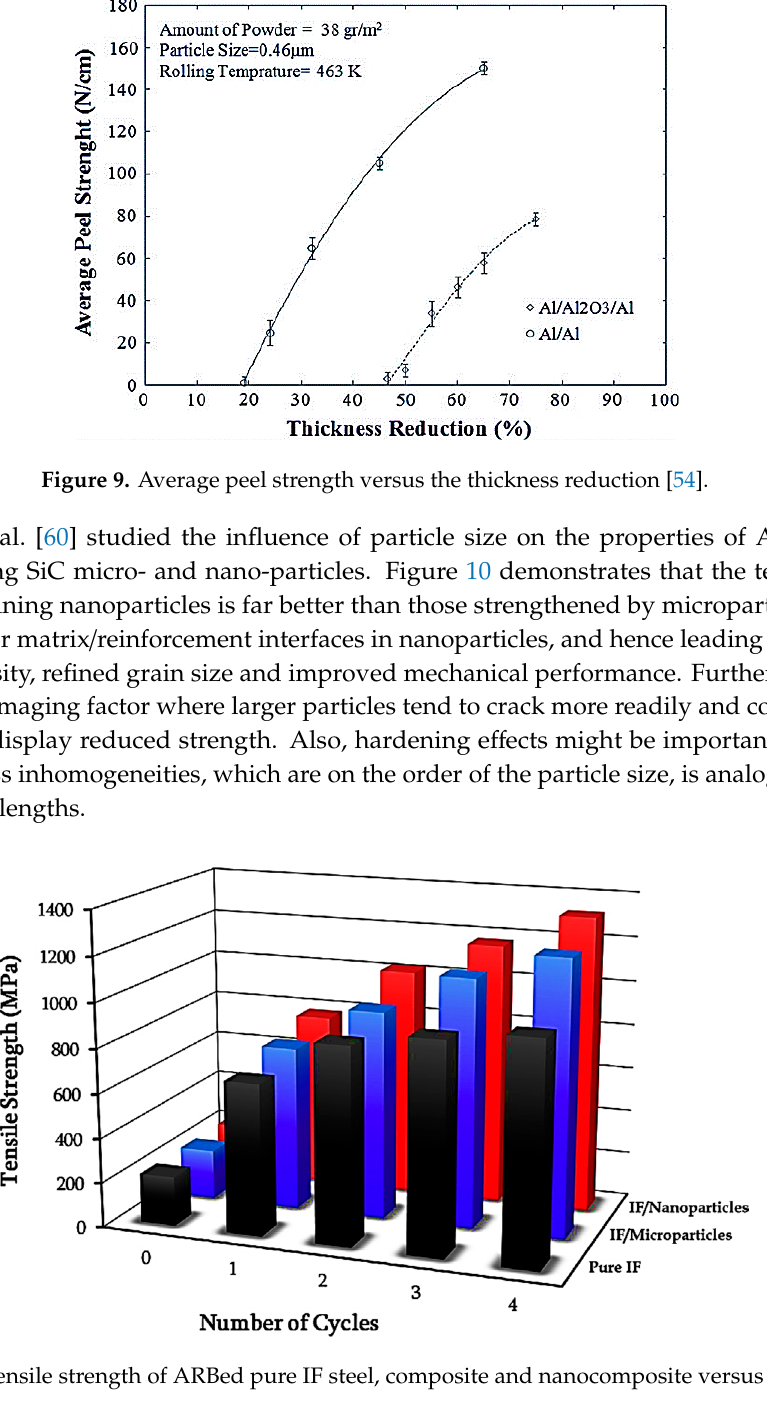
Figure 9. Average peel strength versus the thickness reduction [54].